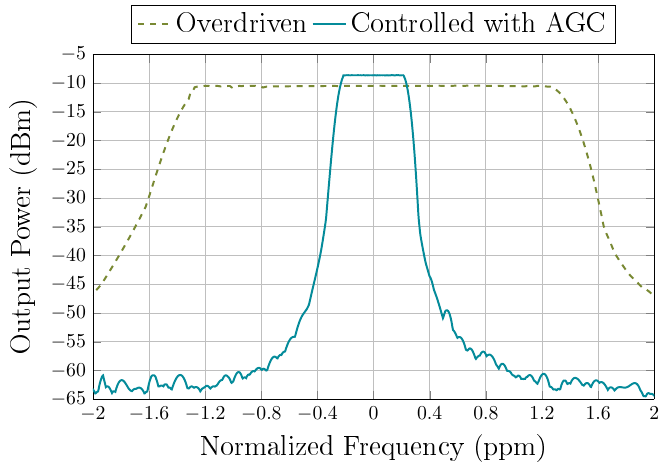
Figure 13. MEMS oscillator signal short time stability at a 17.93 MHz central frequency (averaged over a five-minute timespan) with a polarization voltage of